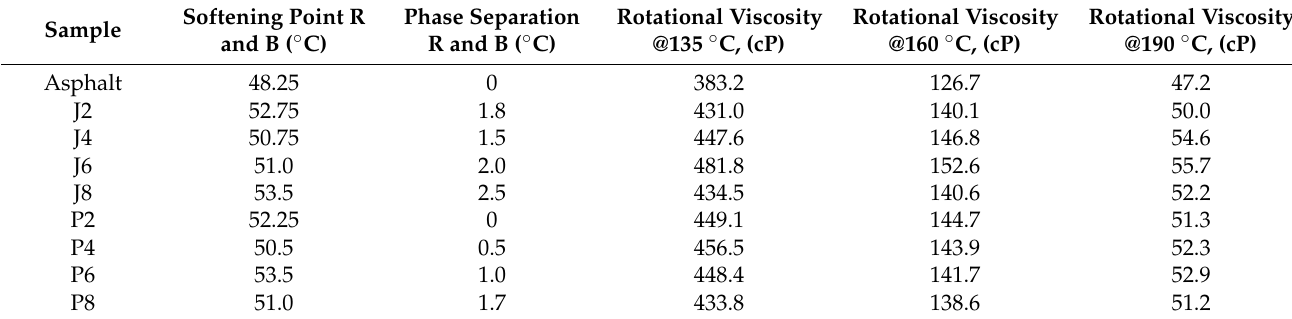
Table 2. Softening point, phase separation, and rotational viscosity results of pure asphalt and the Jatropha - and pistachio- modified asphalt